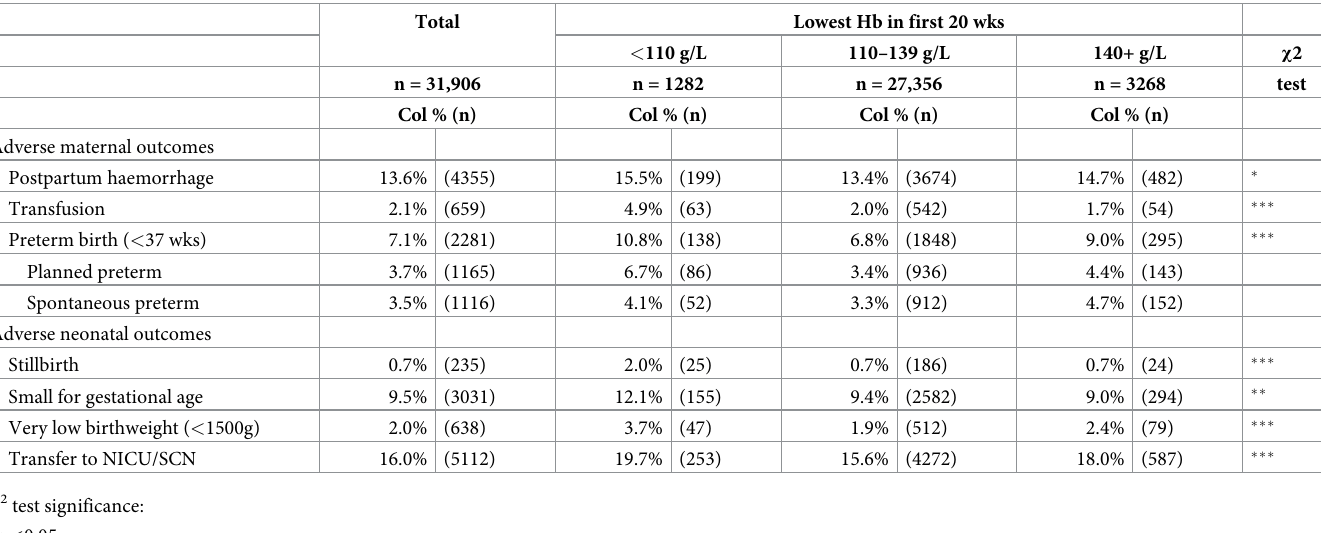
Table 2. Outcomes by lowest haemoglobin (Hb) at 20 weeks gestation or